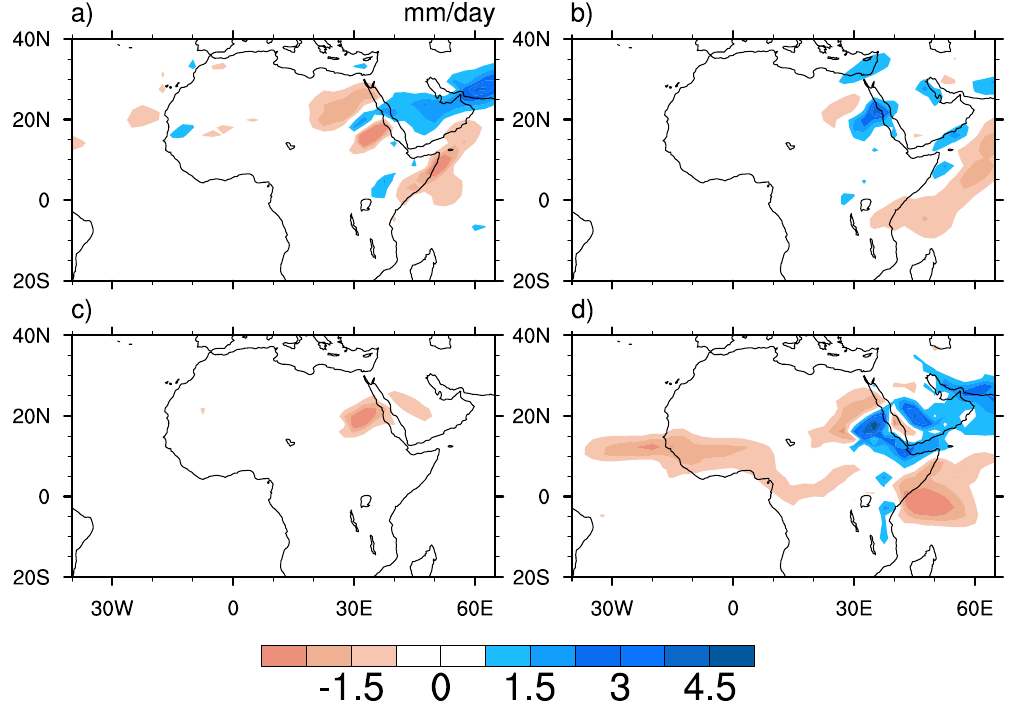
Figure 4. Differences in JAS moisture convergence. ( a ) between SEN_A and CON. This figure was generated by the NCAR Command Language (Version 6.3.0) [Software]. (2016). Boulder, Colorado: UCAR/NCAR/CISL/TDD.